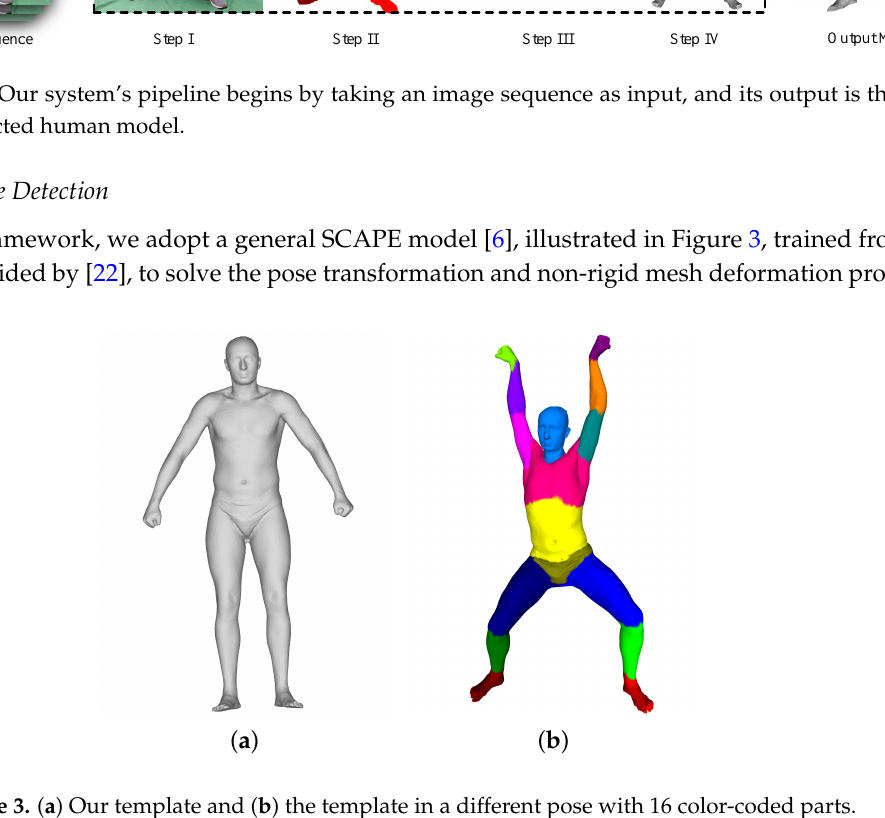
Figure 3. ( a ) Our template and ( b ) the template in a different pose with 16 color-coded